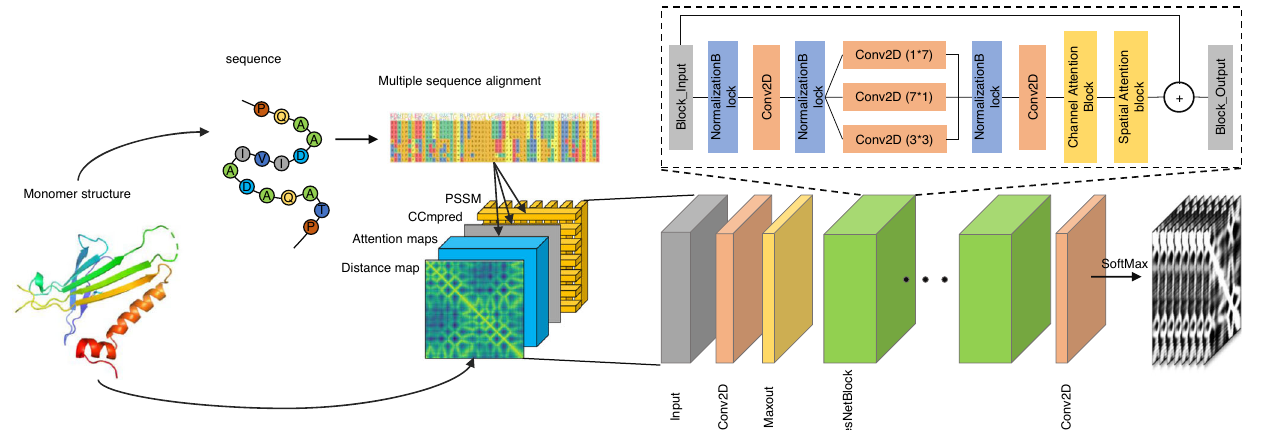
Fig. 6 | Overview of the CDPred architecture. CDPred simultaneously uses the tertiary structural information (i.e., intra-chain distance map of monomers), sequential information (PSSM), and residue-residue co-evolutionary information (i.e., co-evolutionary scores calculated by CCMpred and attention maps by MSA transformer) as input to predict inter-chain distance maps. The dimension of the input for the homomer dimer is L×L×186 (L is the length of the monomer sequence), while the dimension of the input for the heterodimer is (L1+L2) x